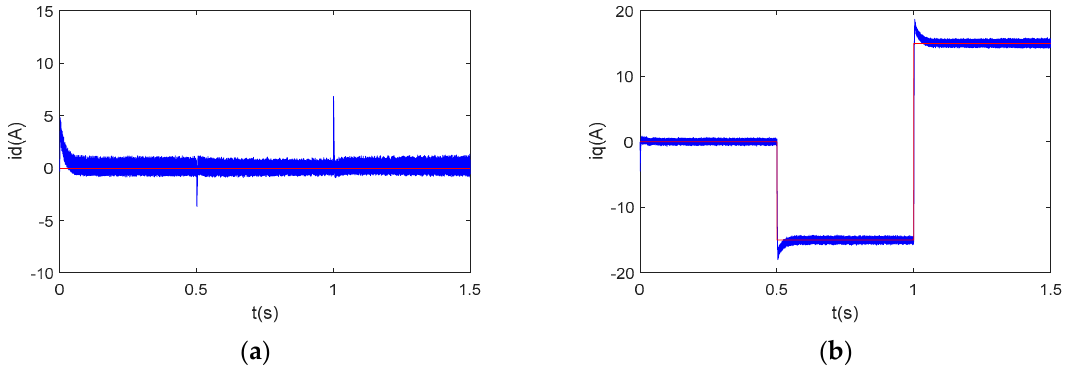
Figure 6. d-q axis current waveform of the conventional current controller with feedback decoupling at 6000 rpm. ( a ) d-axis current; ( b ) q-axis current.